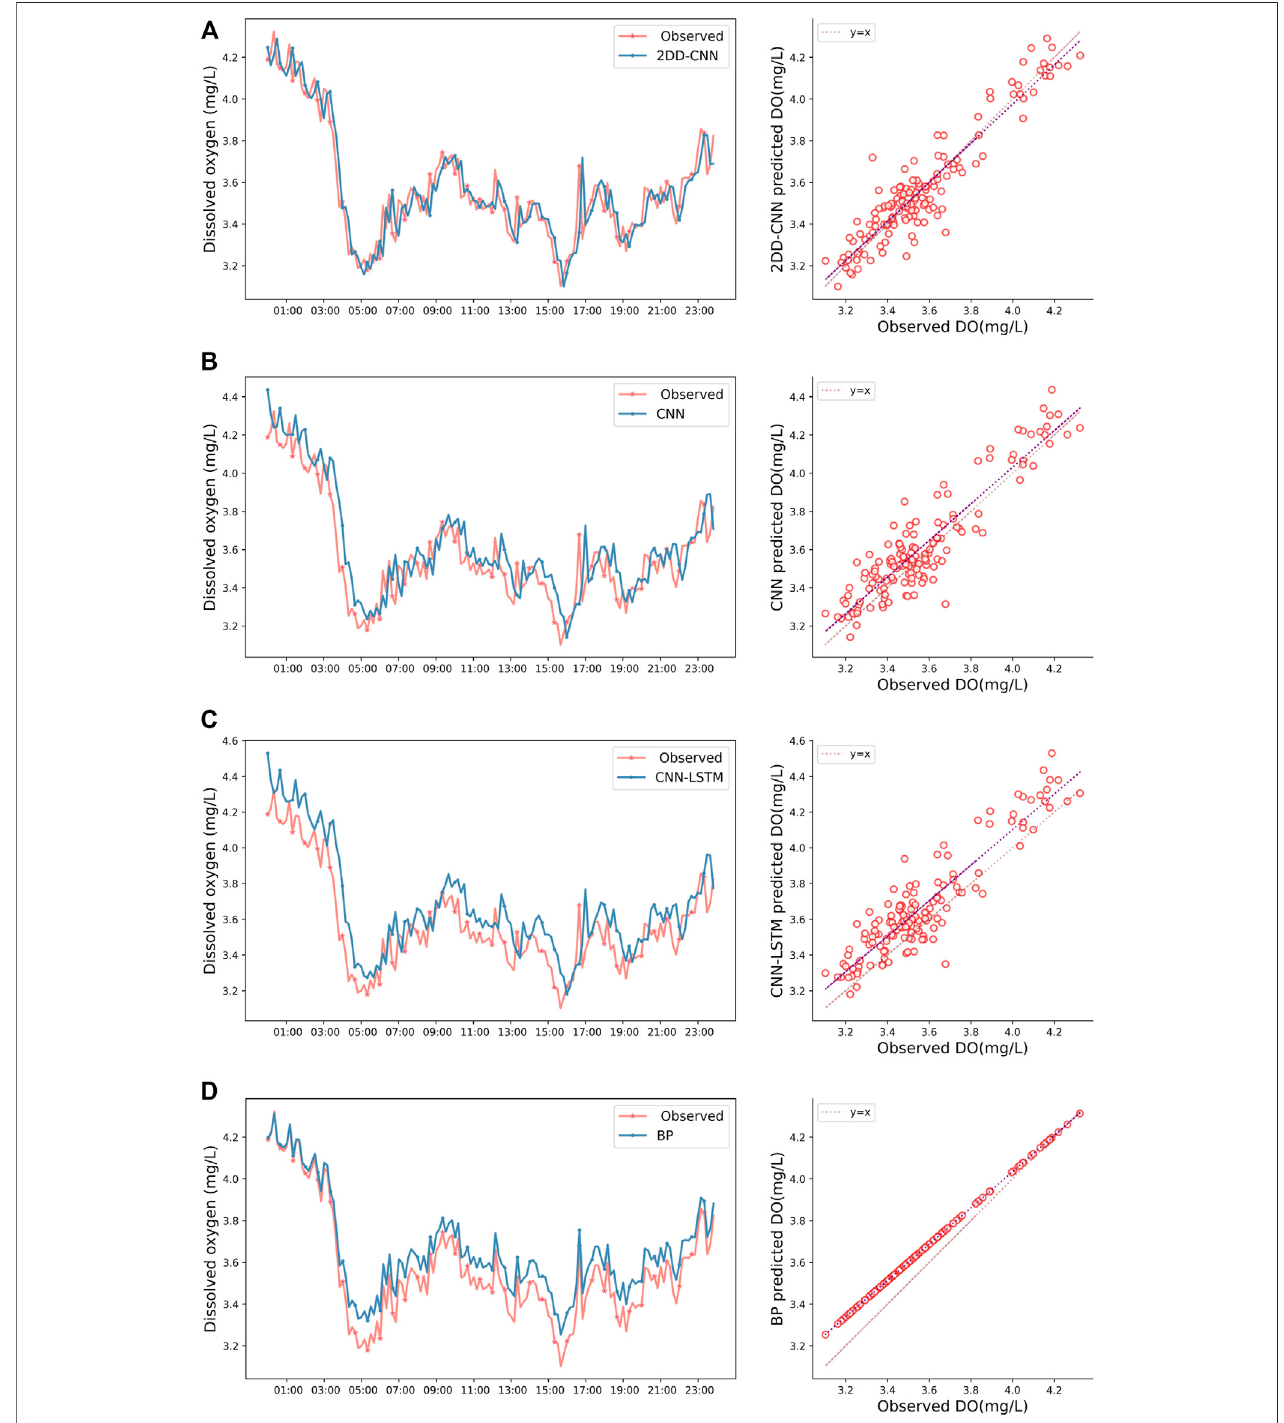
FIGURE9| ComparisonofpredictedandobservedvaluesofDOformultiplemodels. (A) istheresultof2DD-CNN. (B) istheresultofCNN. (C) istheresultofCNN- LSTM. (D) istheresultofBP. (E) istheresultofLSTM. (F) istheresultofDT. (G) istheresultofRF. (H) istheresultofDENFIS. (I) istheresultofLSTM-ALO. (J) istheresult of OP-ELM. (K) is the result of LSSVM-GSA. (L) is the result of GMDH.